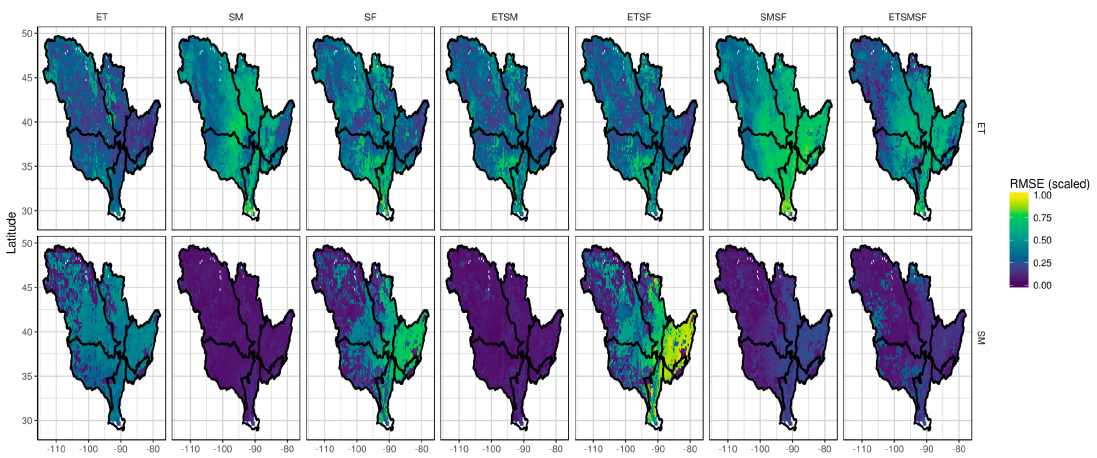
Figure 3. Bar plots of scaled RMSE values of basin averaged monthly ET (top panel), SM (middle cases. The maximum values are provided in the header of each panel within square brackets. The panel), and SF (bottom panel) when the Noah-MP model is calibrated with 1) ET, 2) SM, 3) SF, 4) multivariate calibration results are derived by taking 10 samples from different points on the Pareto fronts. We also present KGE values for each of the calibration cases above each barplot. For parameter sets are shown.